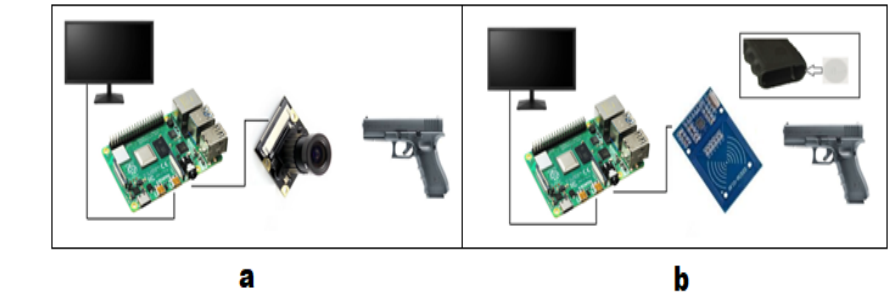
Figure 1 – System architecture: (a) for image testing, (b) for RFID tag processing) Рис . 1 – Системная архитектура : ( а ) проверка изображений , ( б ) для